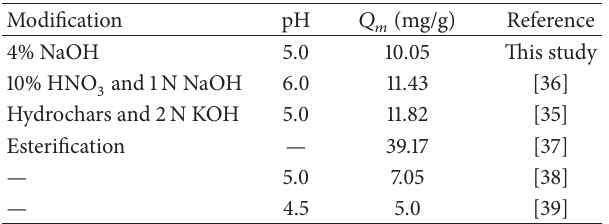
Table 4: Comparison of adsorption capacities of wheat straw for Cu(II)